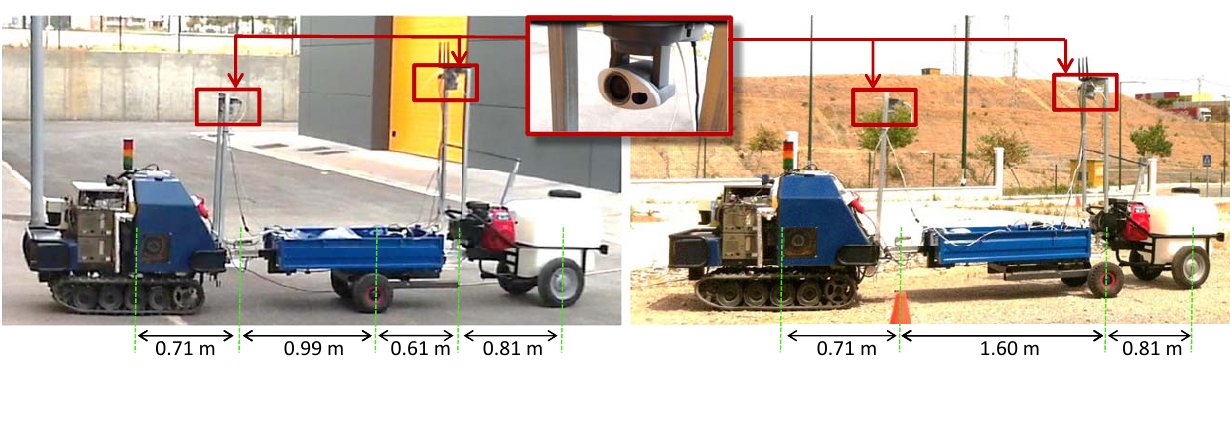
for the leading unit depending on motion direction and m